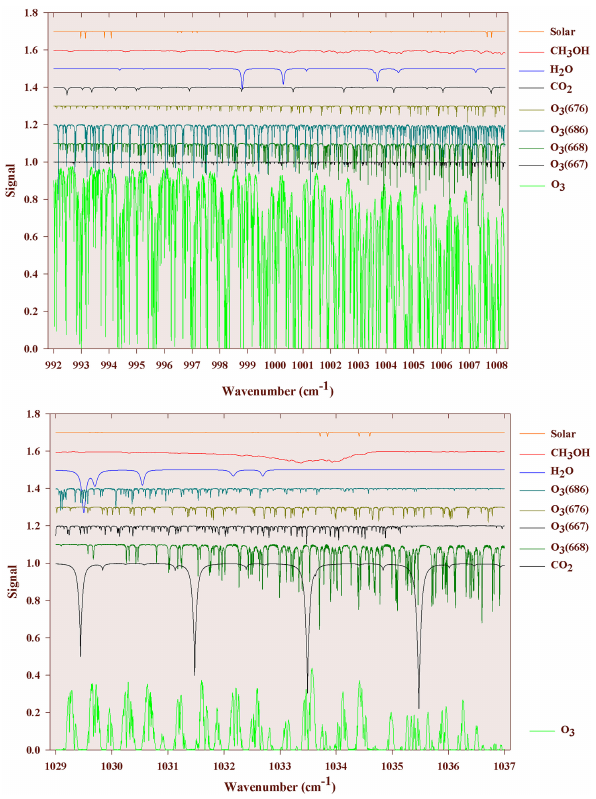
Figure 1. Simulation for Jungfraujoch, 80 ◦ zenith angle, 6.1mK. For both windows, we display the synthetic spectra for individual contributors (see colour codes). HITRAN 2008 and averaged mix- ing ratio profiles based on the WACCM model climatology have been used for the simulations, except for CH 3 OH for which our a priori was used (see text). For clarity, the contributions of each species have been vertically